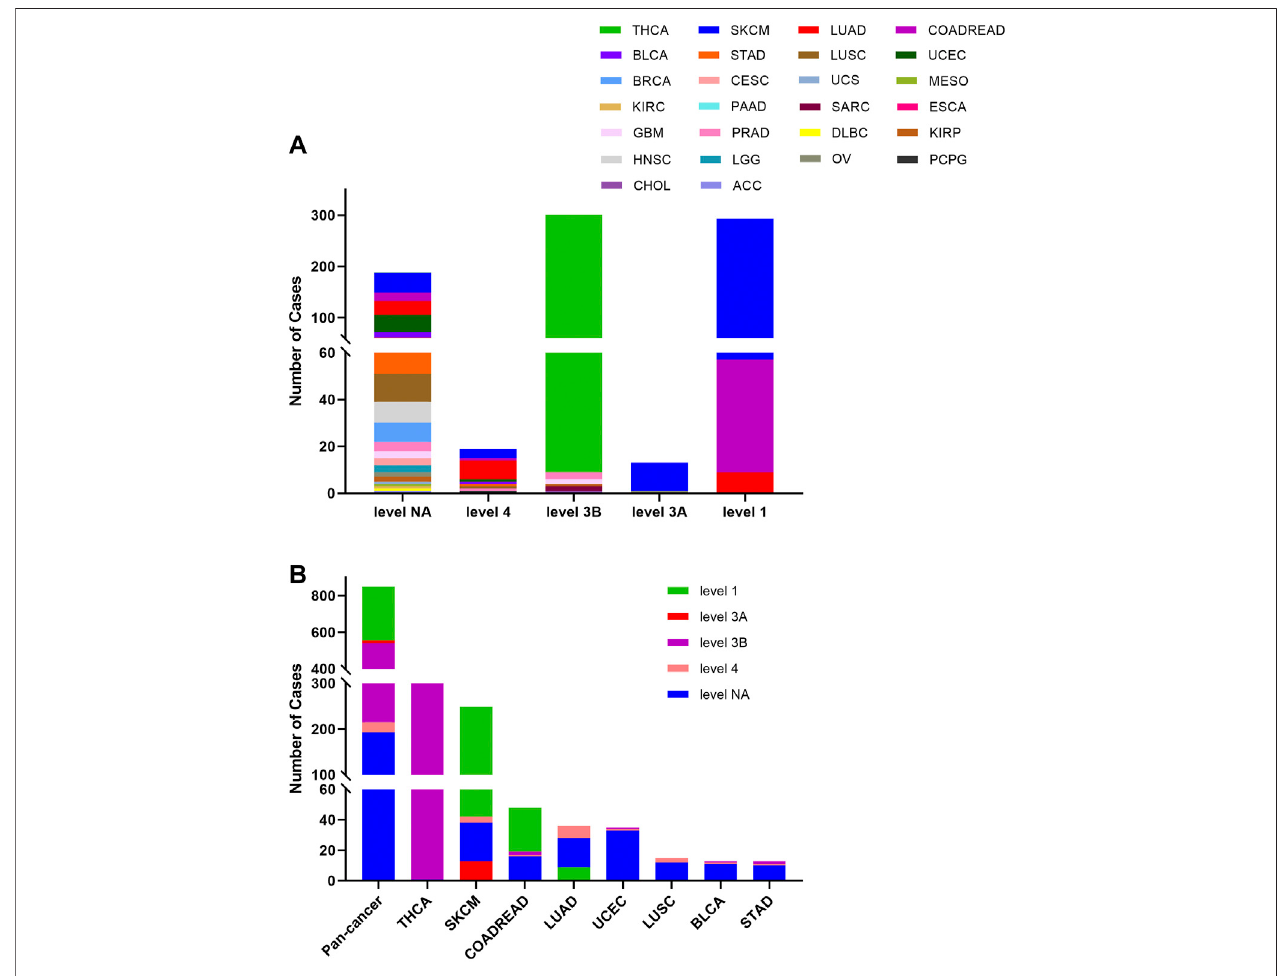
FIGURE 5 | BRAF mutation distribution according to clinical therapeutic implications. (A) BRAF mutation distribution based on the OncoKB therapeutic evidence levels among diverse cancer types. (B) OncoKB therapeutic evidence levels distribution of BRAF mutation in pan-cancer and the top 8 tumor types.